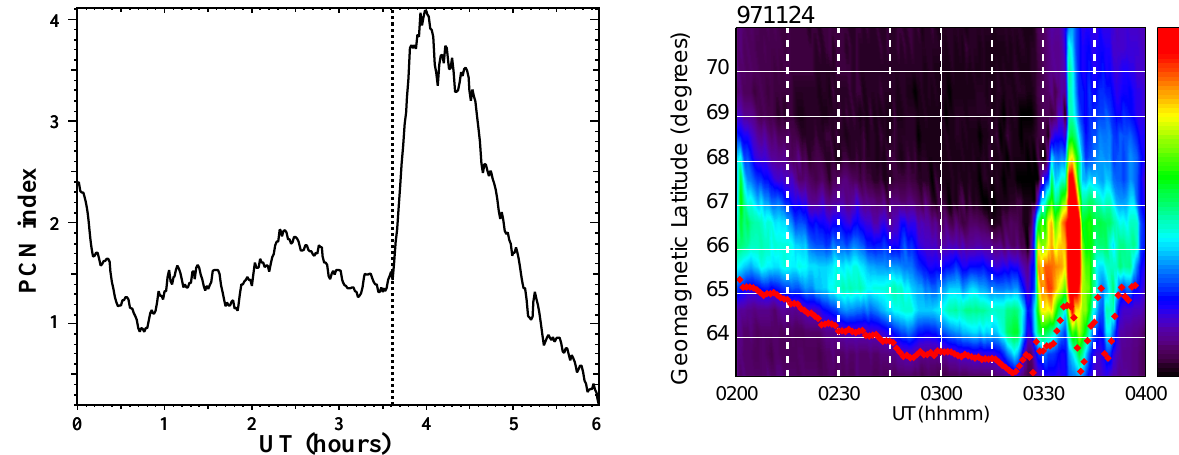
Fig. 9. Proton auroral emission (486 nm) and the location of its equatorward boundary (red diamonds) (Donovan et al.,